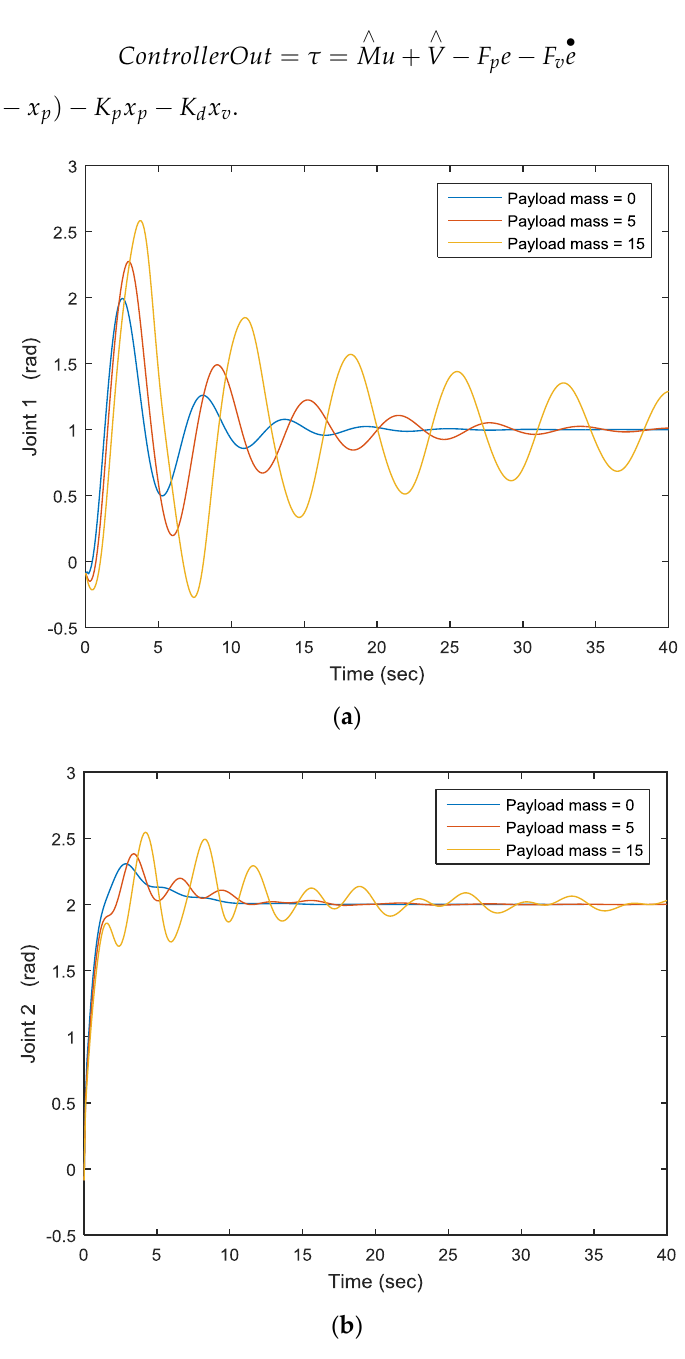
Figure 3. The output of joint 1 ( a ) and joint 2 ( b ).